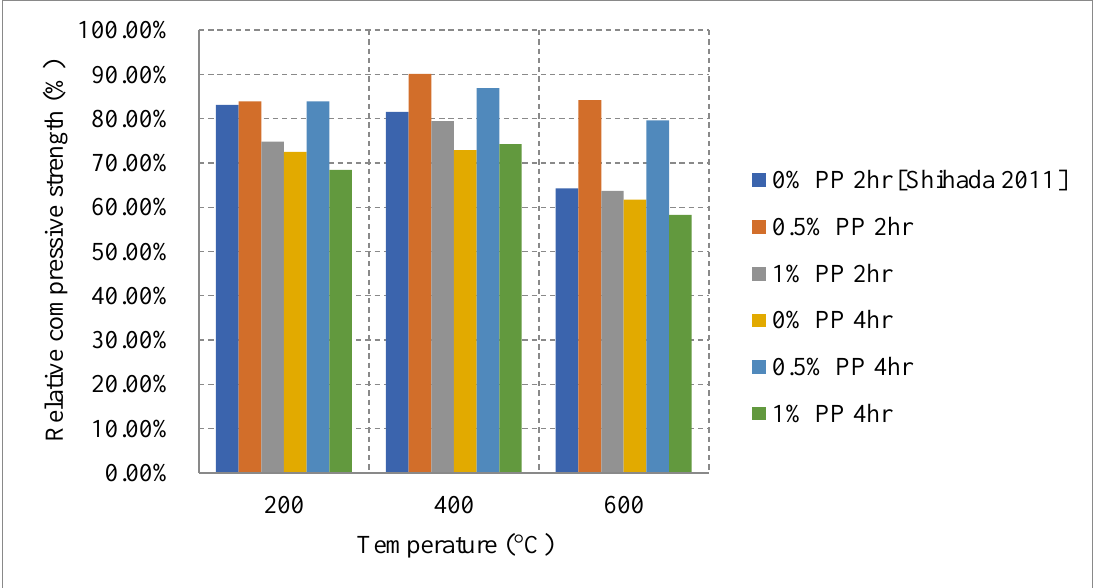
Figure 23. Effect of PP fibers on the relative compressive strength of naturally cooled FRC. 2 hr: 2-h exposure, 4 hr: 4-h exposure [87].